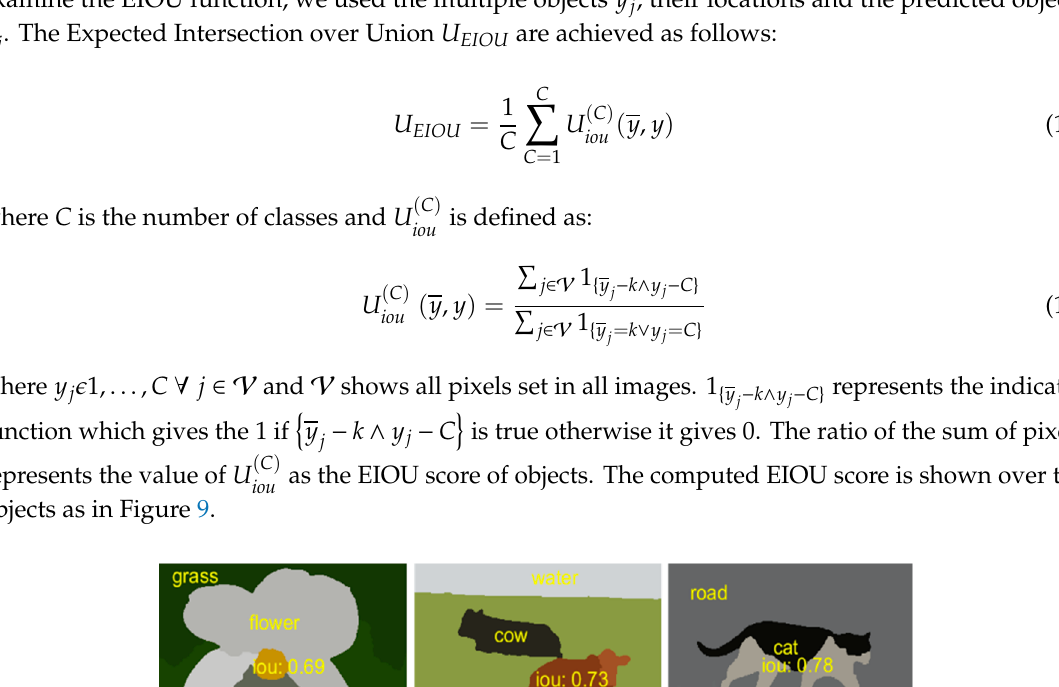
Figure 9. Demonstration of EIOU score over multiple objects at MSRC dataset.